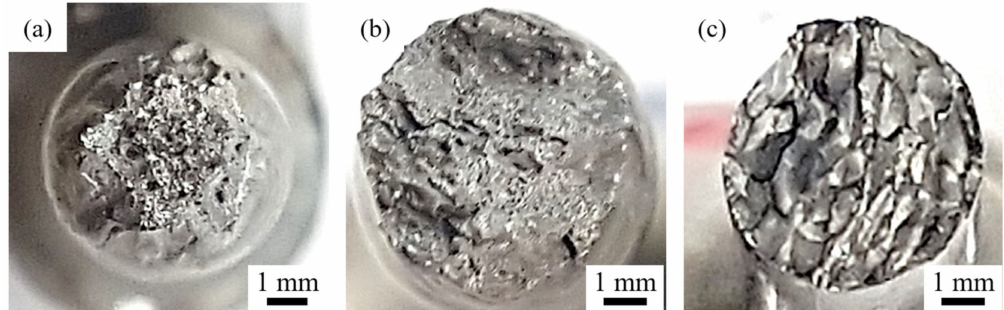
Figure 7. Fractographs of the tensile tested as-swaged TNZ40 alloys: ( a ) TNZ40, ( b ) TNZ40 + 0.1 Si, and ( c ) TNZ40 + 0.2 Si.